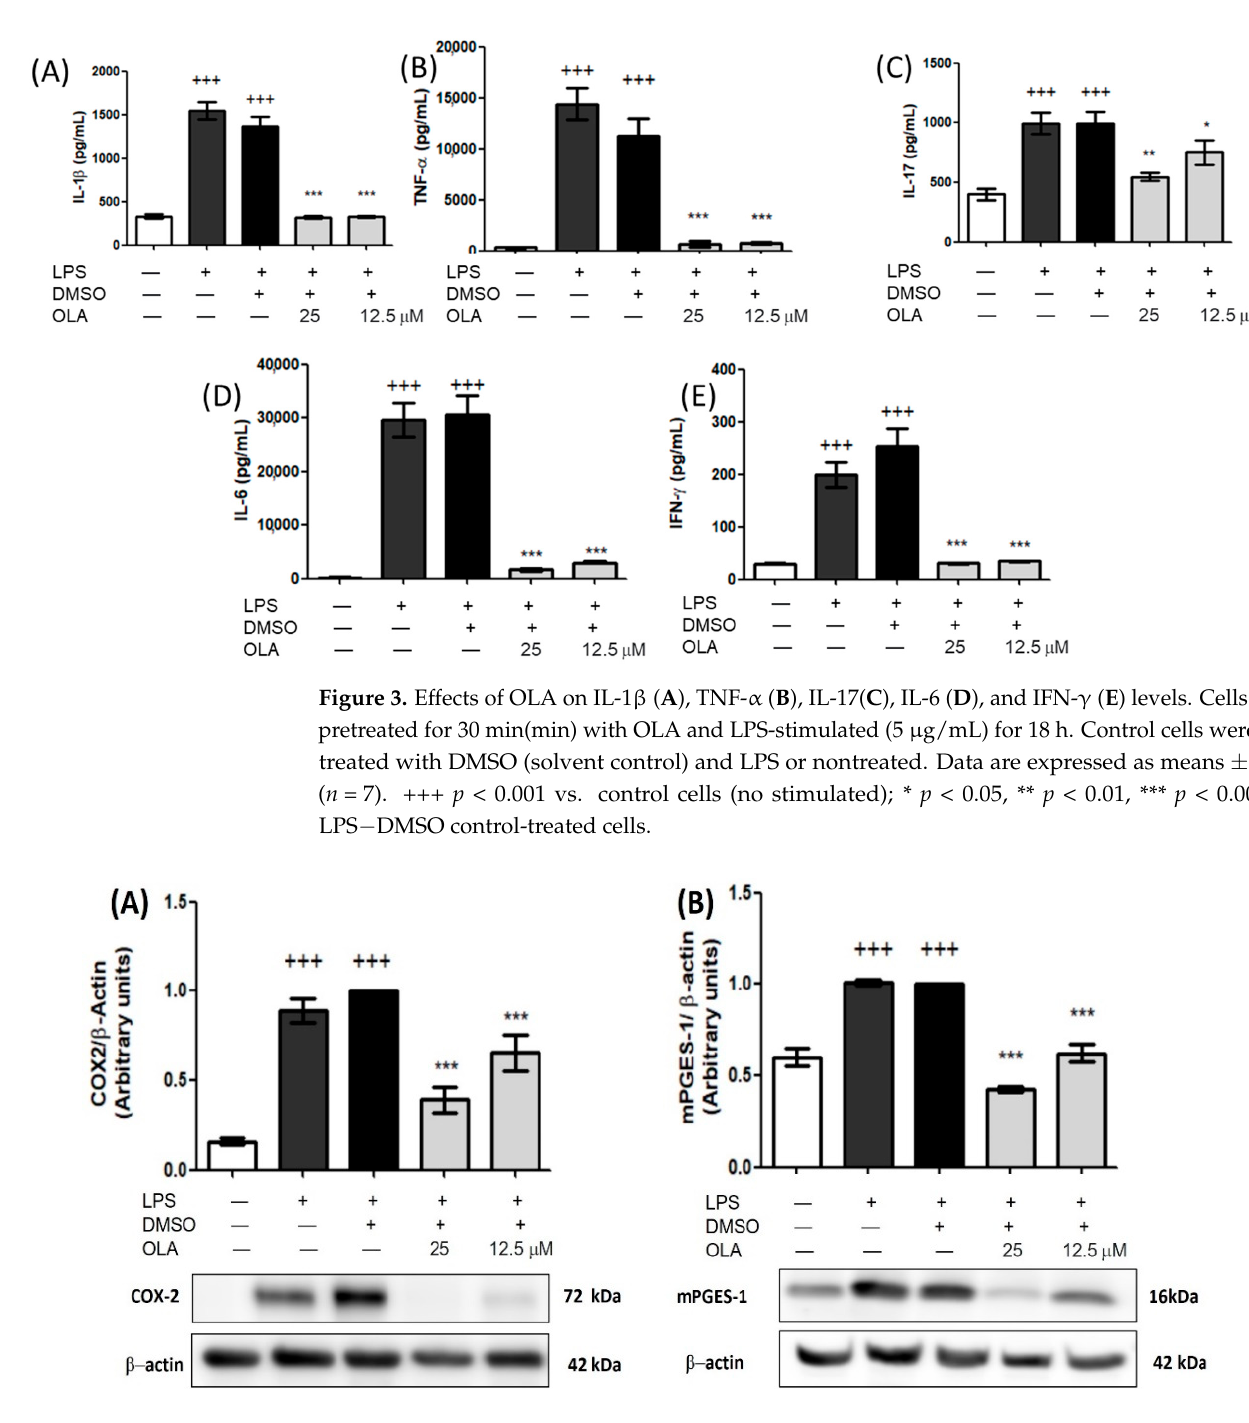
Figure 4. OLA reduced COX-2 and mPGES-1 overexpression in LPS-stimulated murine peritoneal macrophages. ( A ) Western blot analysis of COX-2 expression; ( B ) Western blot analysis of mPGES-1 expression. Cells were pretreated with OLA (25 and 12.5 μ M) and incubated in absence or presence of LPS for 18 h. Densitometry was performed after normalization to the control ( β -actin housekeep- ing gene). Data are represented as mean ± SEM ( n = 6). +++ p < 0.001 vs. control cells (no stimulated); *** p < 0.001 vs. LPS − DMSO cells.